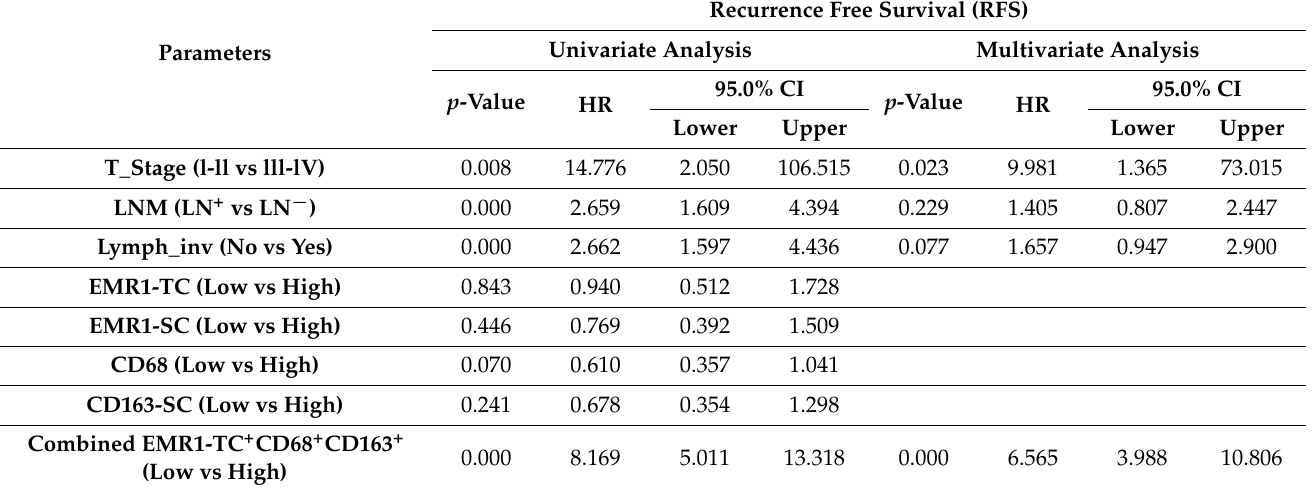
Table 4. Univariate and multivariate analyses of the prognostic factors in patients with CRC using a Cox regression